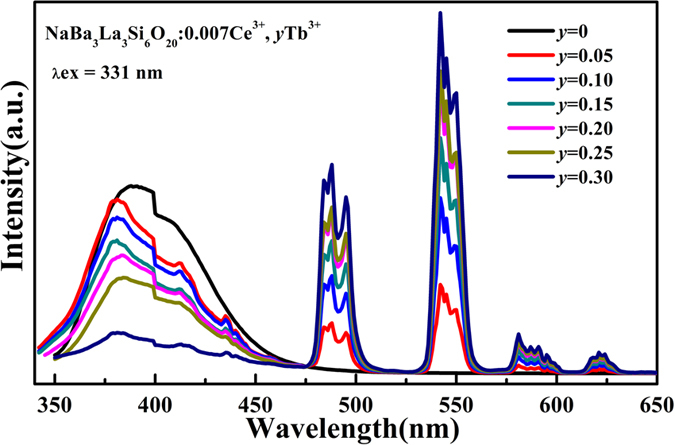
The PL spectra of the NaBa3La3Si6O20:0.007Ce3+, yTb3+ phosphors.